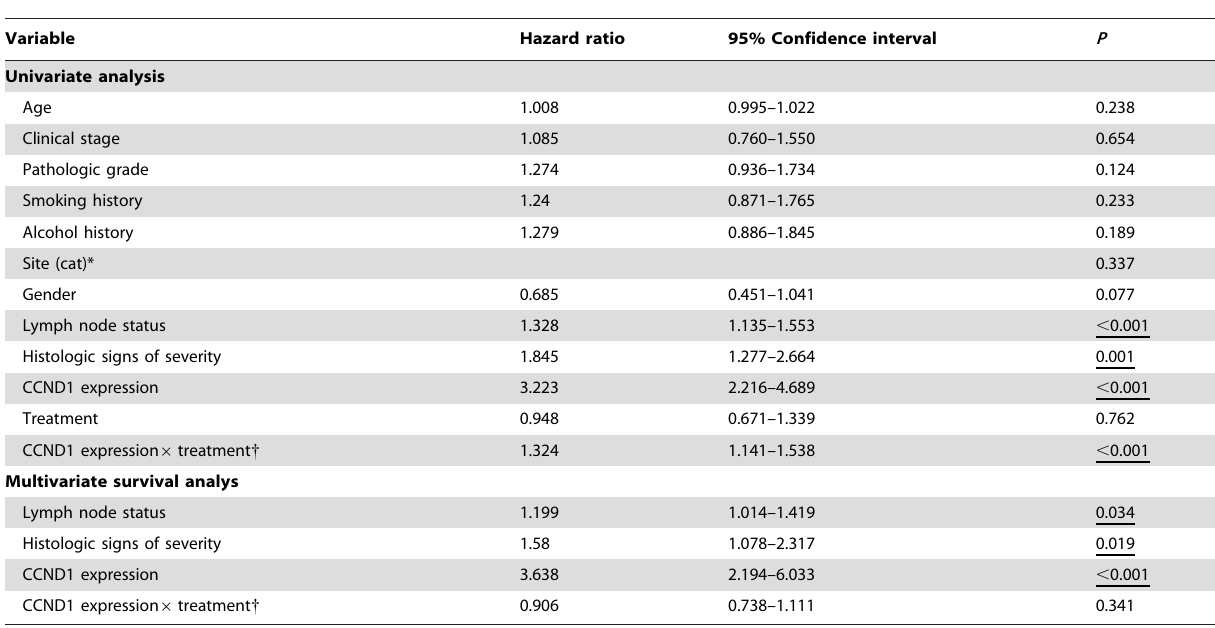
Table 4. Cox proportional hazards regression models in estimating overall